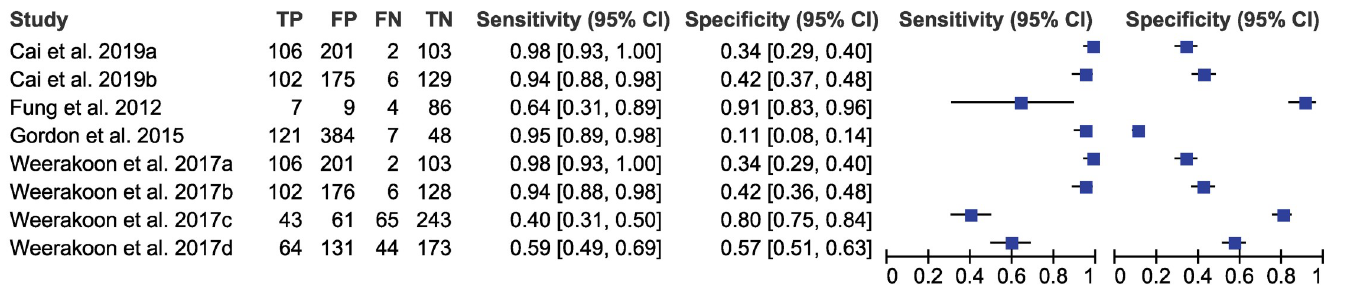
PLOS NeglectedTropical Diseases | https://doi.org/10.1371/journal.pntd.0009244 March 17,